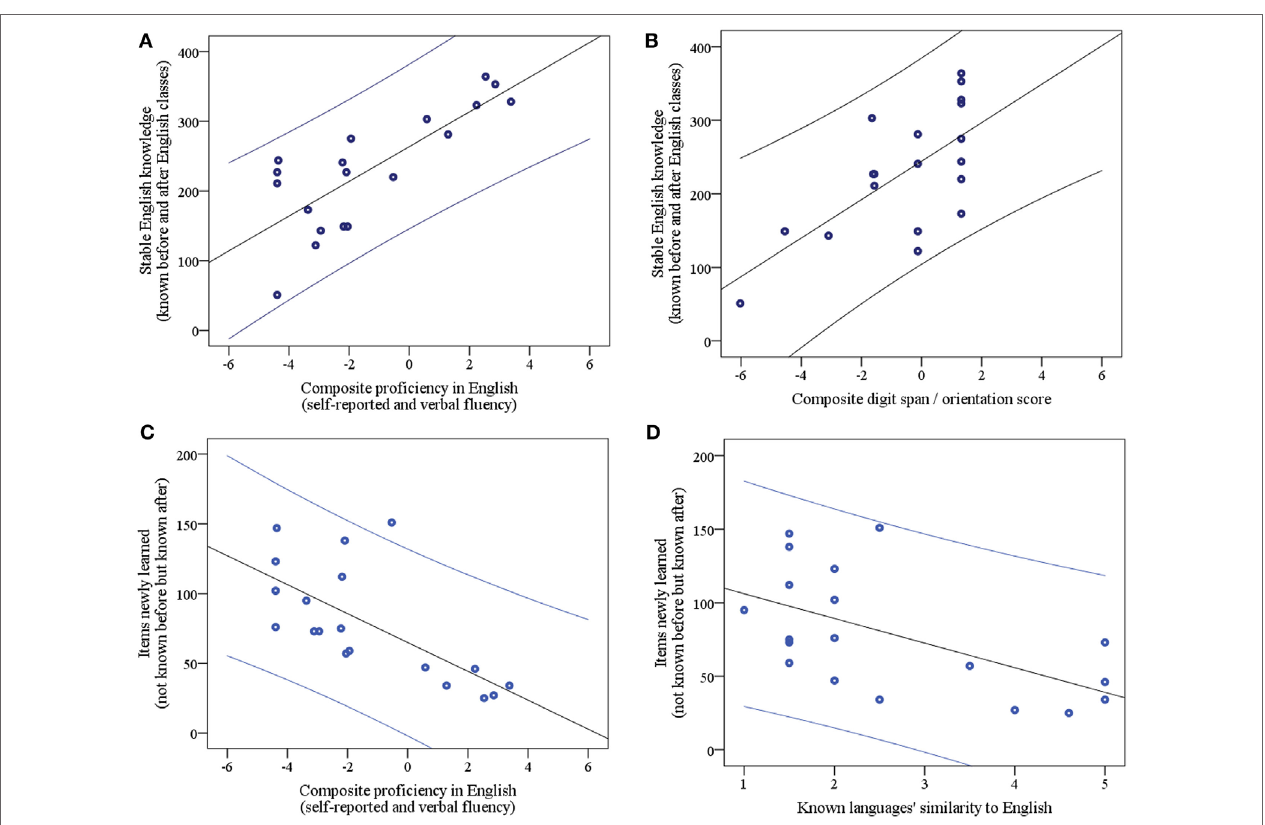
FigUre 5 | English proficiency and digit span/orientation as unique predictors of learners’ stable English knowledge (a,b) and English proficiency and known languages’ similarity to English as unique predictors of number of items newly learned during English instruction (c,D) . Pairwise correlations are plotted with error lines representing 95% confidence